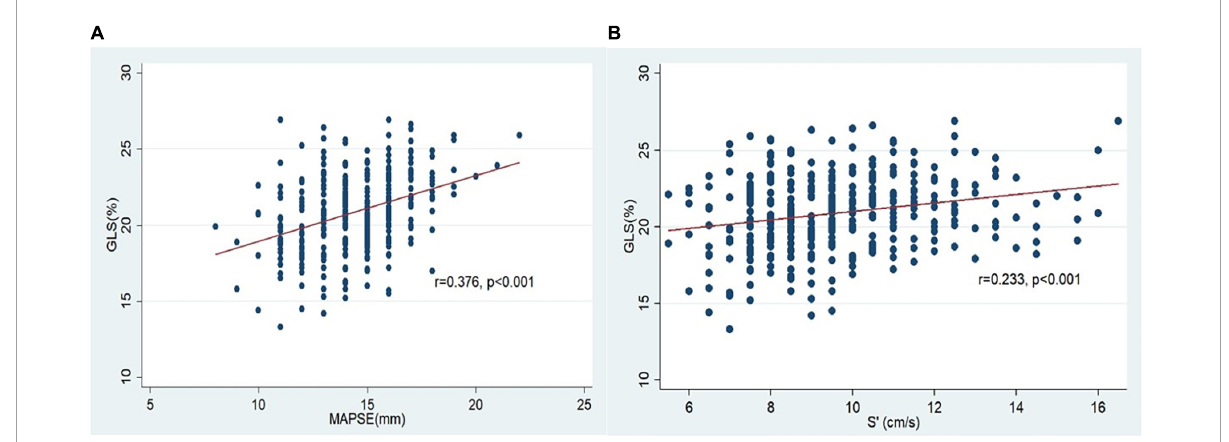
FIGURE3 Correlation of GLS and MAPSE/S’ at the baseline. (A) Correlation of GLS and MAPSE; (B) correlation of GLS and S’.